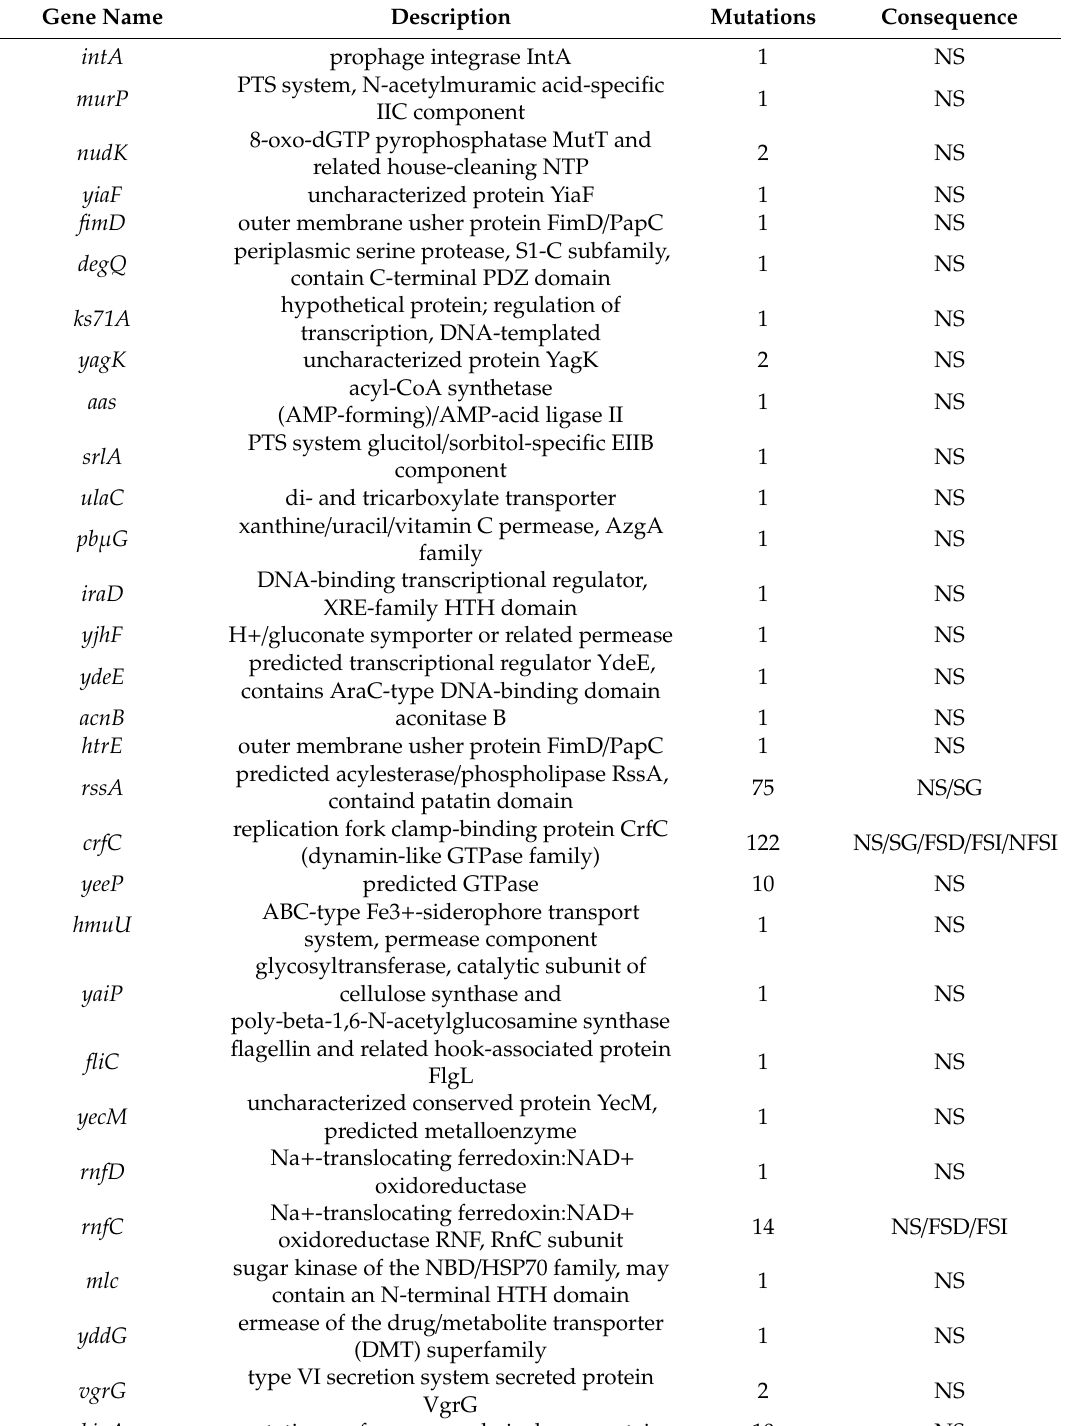
Table 3. Non-synonymous mutations in resistant E. coli ATCC25922 induced by sub-MIC of